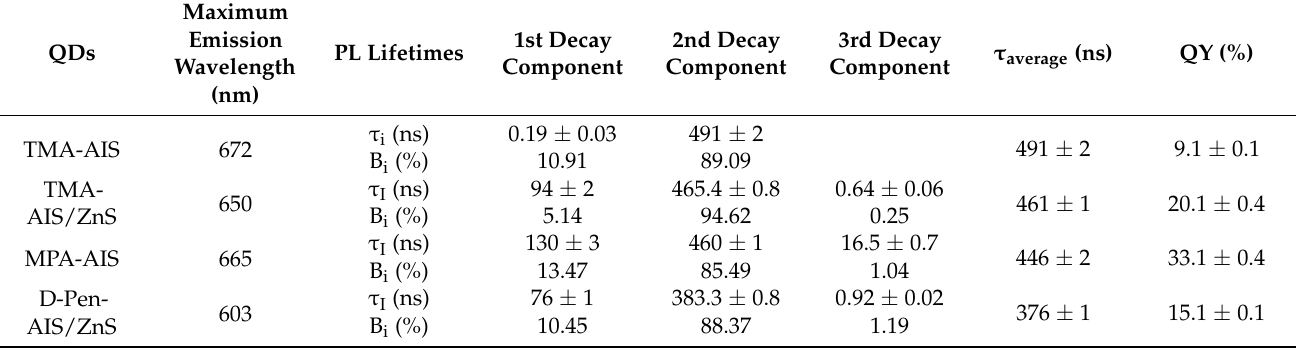
Table 2. PL lifetime values of each synthesized ternary AgInS 2 quantum